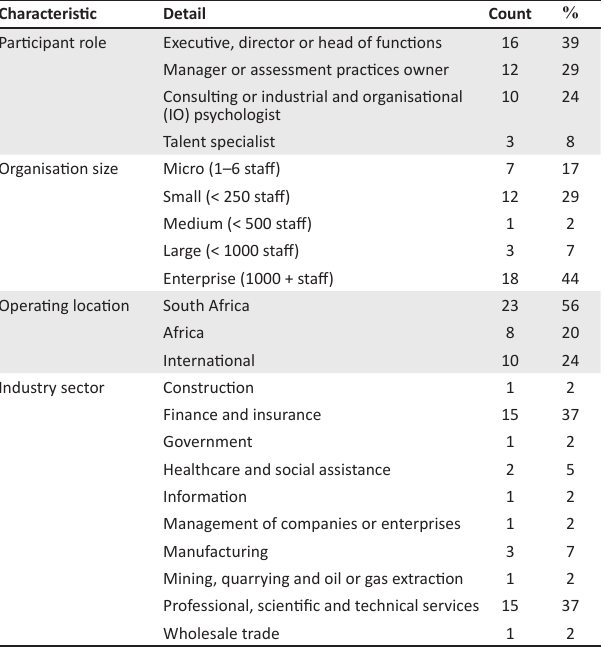
TABLE 1: Description of participating organisations. Characteristic Detail Count